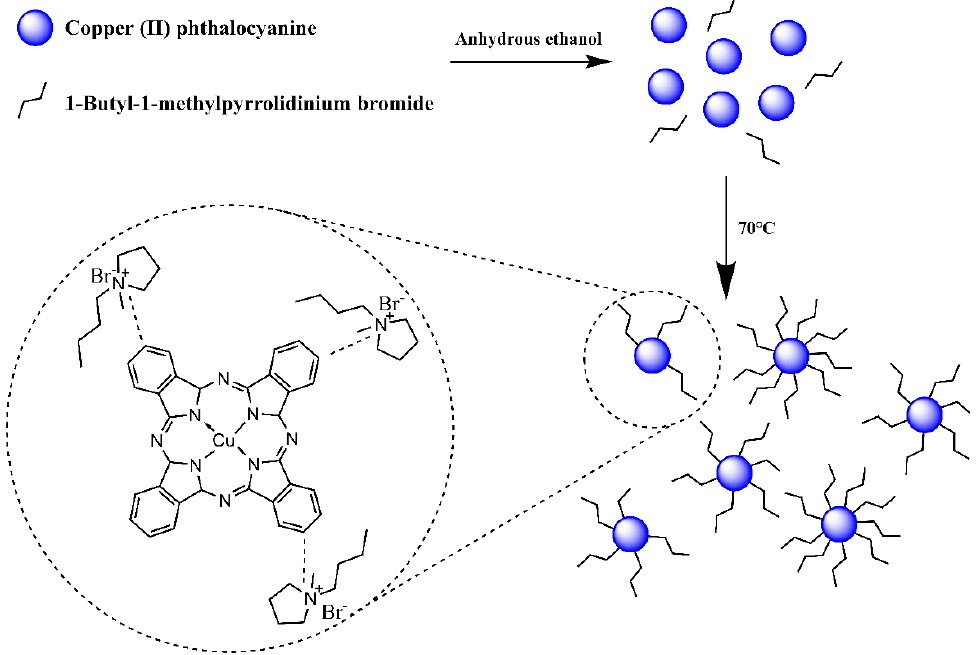
Figure 1. Schematic diagram of modification process and principle of Copper (II) phthalocyanine (CP) use 1-Butyl-1-methylpyrrolidinium bromide (IL), and the structure of the CP modified with IL (CP-IL).